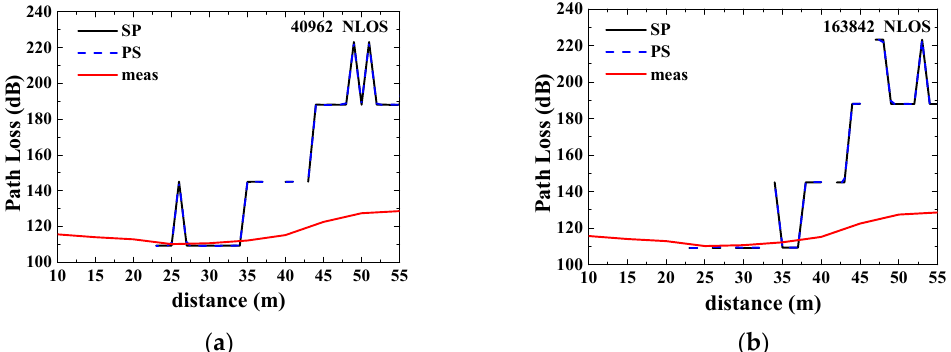
Figure 10. Path loss comparison of theoretical calculation with measured data for 40,962 and 163,482 rays in the NLOS, respectively. ( a ) The number of rays is 40,962 ( b ) The number of rays is 163,482.